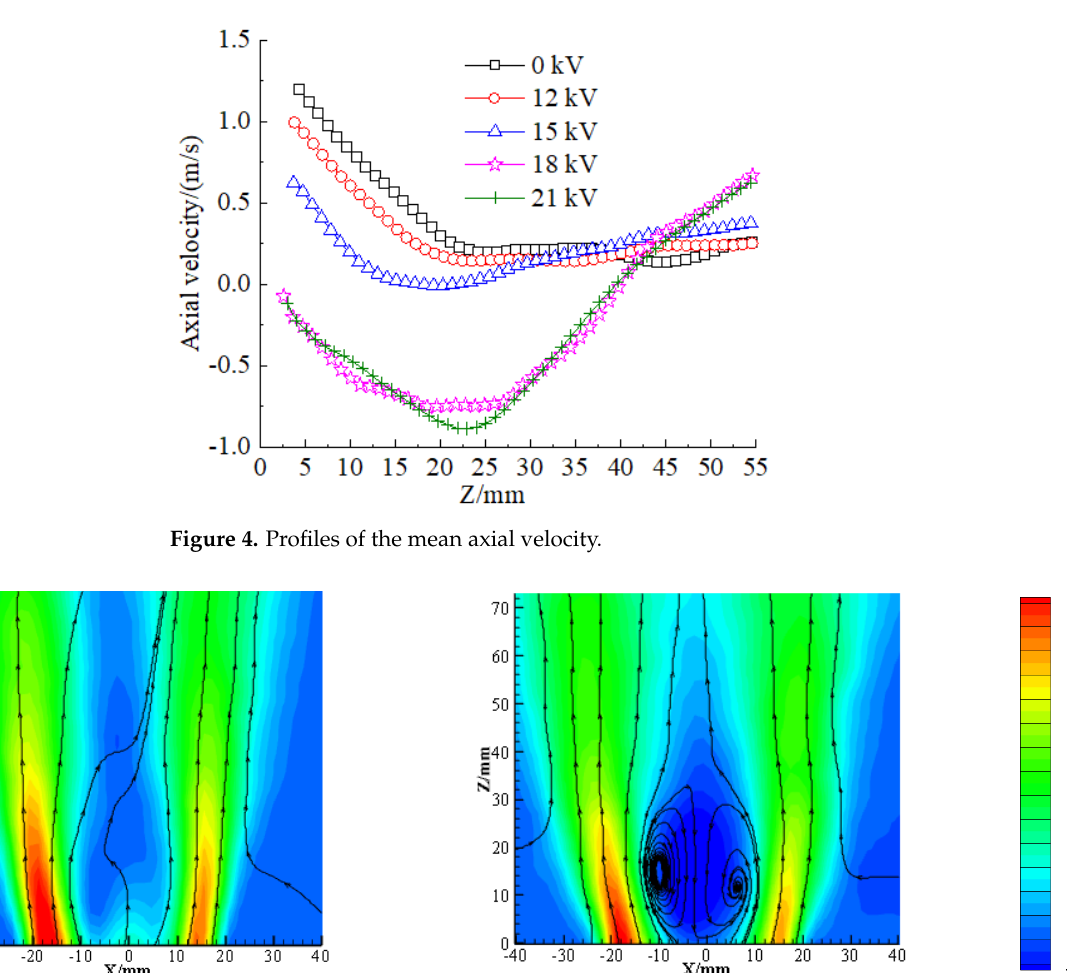
Figure 4. Profiles of the mean axial velocity.